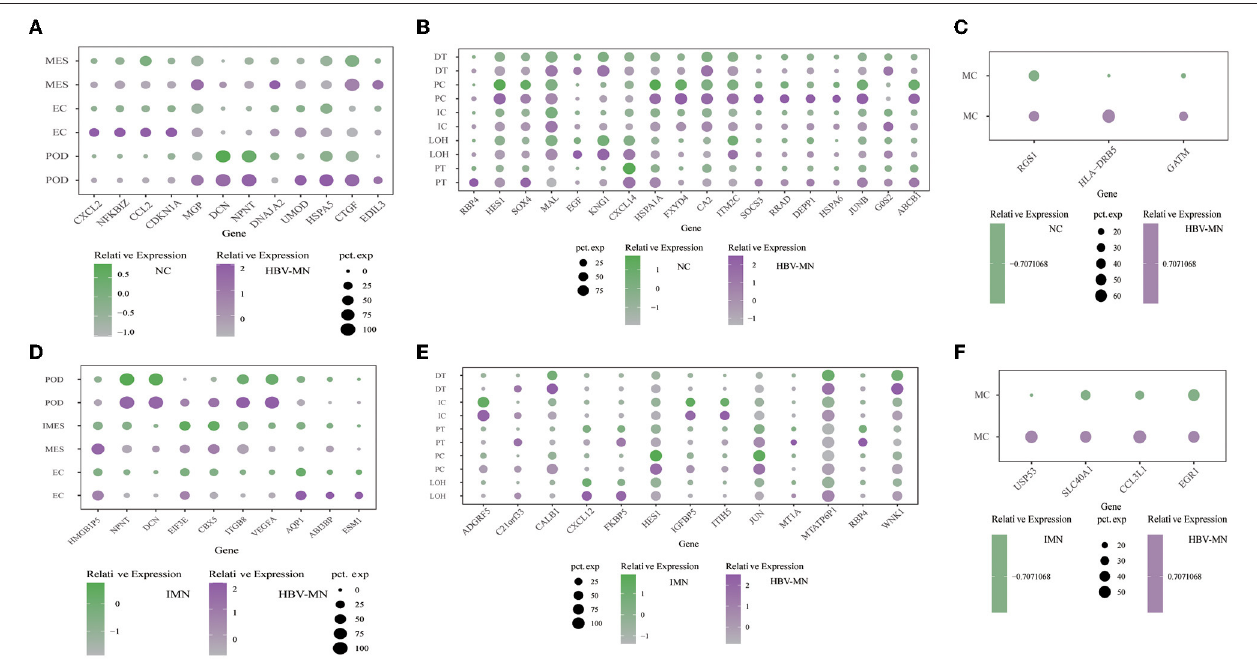
FIGURE 2 | DEGs in the kidney cells between HBV-MN and healthy/IMN subjects. (A–C) Representative DEGs in glomerular cells, tubular cells, and immune cells comparing the HBV-MN patients to the healthy donors, respectively. pct. exp, percentage of cells expressing gene. (D–F) Representative DEGs in glomerular cells, tubular cells, and immune cells comparing the HBV-MN patients to IMN subjects. pct. exp, percentage of cells expressing gene,